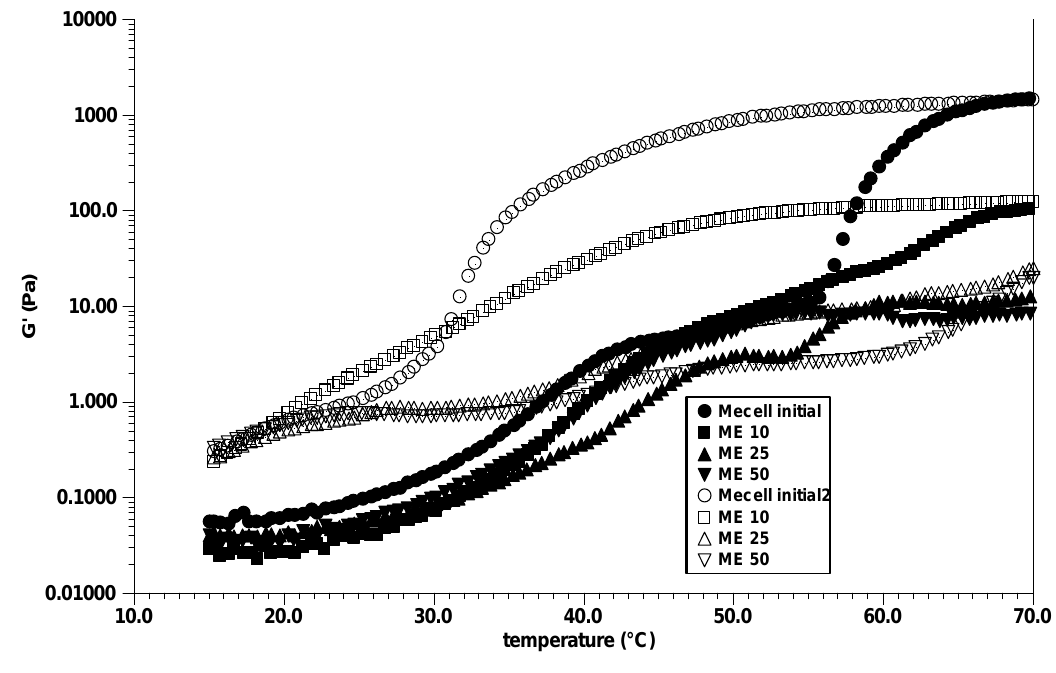
Figure 9. Influence of temperature on the storage modulus G’ (Pa) of methylcellulose and oxidized derivatives at 30 g/L in water. Filled symbols for increase of temperature; open symbols for decrease of